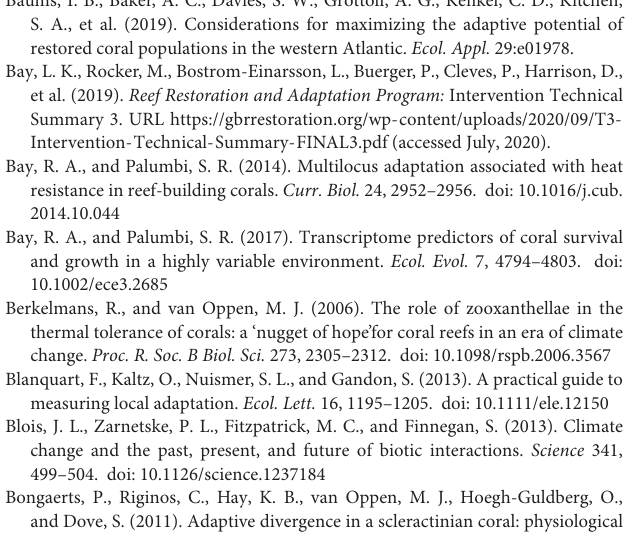
Supplementary Table 8 | Heat stress pairwise contrasts based on estimated marginal means among different temperatures and contrasts of treatment groups. Bold values indicate statistical significance. Supplementary Table 9 | Pairwise F ST values (bottom diagonal) and F ST p -values (top diagonal) between surviving colonies after 12 months of reciprocal transplantation (March 2013) for 16 single nucleotide polymorphism (SNP) outliers. Bold p -values indicate statistical significance. FF = flat to flat, FS = flat to slope, SF = slope to flat, SS = slope to slope, G = Gardens site, C = Canyons site. Supplementary Table 10 | Permutational multivariate analysis of variance of the Symbiodiniaceae composition in native treatment groups (FF, SS) between sampling time points in April 2012 and March 2013. Bold values indicate statistical significance. Supplementary Table 11 | Permutational multivariate analysis of variance of the Symbiodiniaceae composition across source and transplant habitats (flat, slope) and sites (Canyons, Gardens) in March 2013 only. The combination of Source:Transplant refers to treatment group. Bold values indicate statistical significance. Supplementary Table 12 | Permutational analysis of homogeneity of multivariate dispersions of the Symbiodiniaceae composition between site and treatment group combinations in March 2013 only. Supplementary Table 13 | Pairwise permutational multivariate analysis of variance of Symbiodiniaceae community composition among site and treatment group comparisons in March 2013 only. Bold values indicate statistical significance. Supplementary Table 14 | Permutational multivariate analysis of variance of the Canyons reef site Symbiodiniaceae community composition by source and transplant habitats (flat and slope) and physiological traits, percent partial mortality (PMORT) and percent cumulative weight gain (PCWEIGHT). Bold values indicate statistical significance. Supplementary Table 15 | Permutational multivariate analysis of variance of the Gardens reef site Symbiodiniaceae community composition by source and transplant habitats (flat and slope) and physiological traits, percent partial mortality (PMORT) and percent cumulative weight gain (PCWEIGHT). Bold values indicate statistical significance. Figure 3